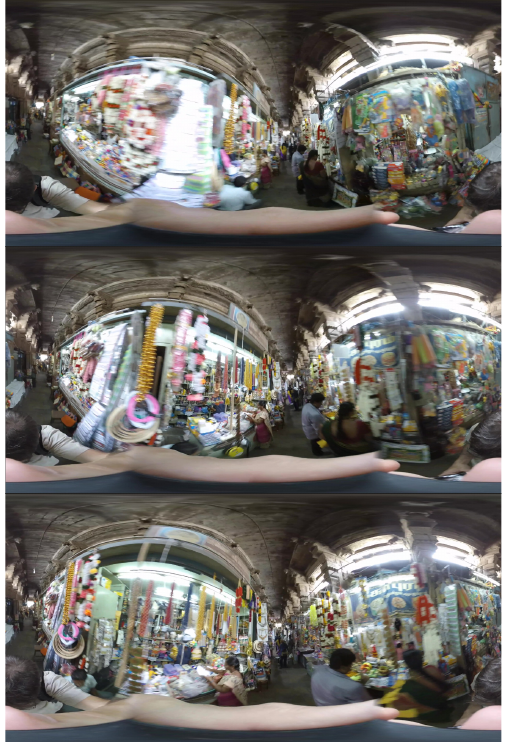
Figure 15 . Three frames extracted from the videos.